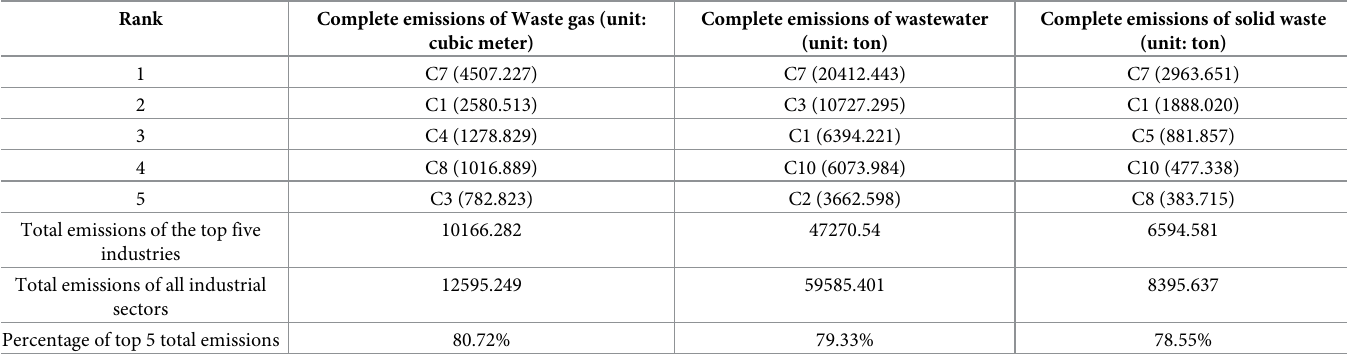
Table 3. Top 5 industries with complete emissions.